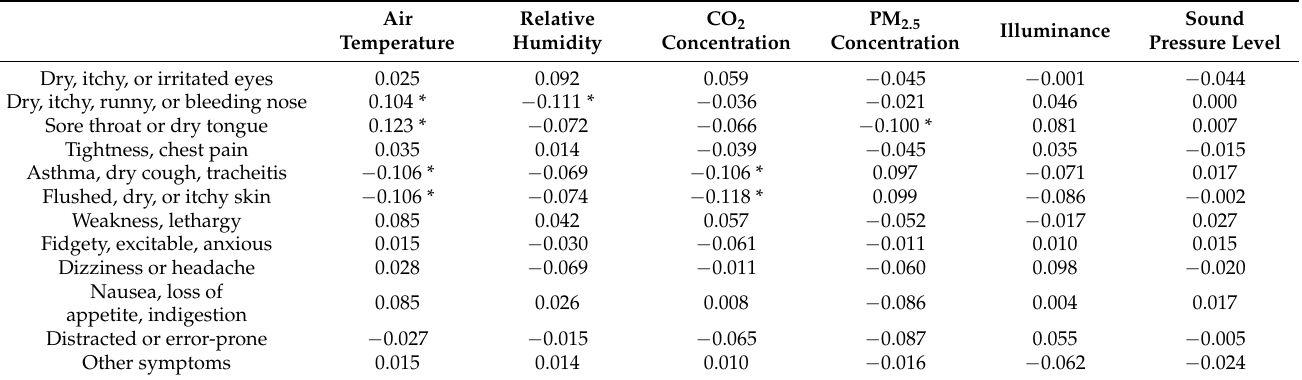
Table 8. Relationship between indoor environment and occurrence of SBS symptoms.